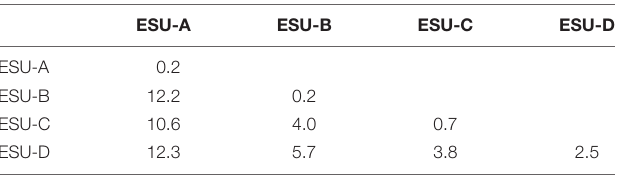
TABLE 1 | Estimates of evolutionary divergence between sequences using the COI gene and the K2P model.